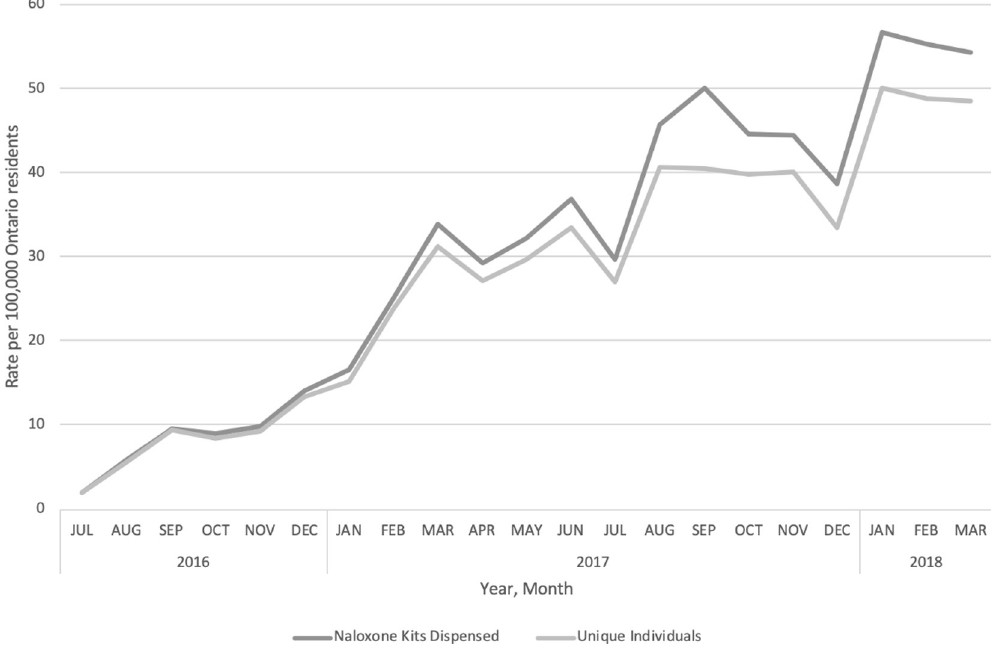
Fig 1. Monthly uptake of the ONPP per 100,000 Ontario residents between July 2016 and March